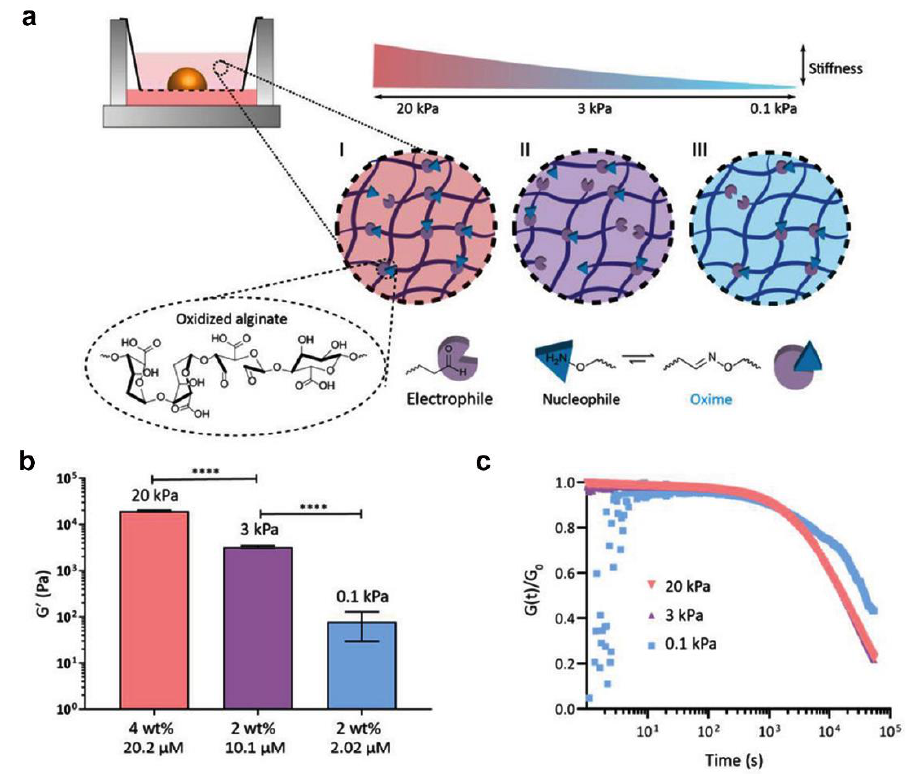
Figure 11. Schematic of the oxime-crosslinked hydrogel system with varying stiffness. ( a ) Schematic diagram of the different hydrogel systems based on oxidized alginate cross-linked with oxime. The I–III plot represents the increase in stiffness of the hydrogel as the cross-linking density increases. ( b ) The shear moduli of different hydrogel compositions (**** significance level of p < 0.0001). ( c ) Stress relaxation of the hydrogels. (Reprinted/adapted with permission from Ref. [82], 2022, Ruiter et al.).